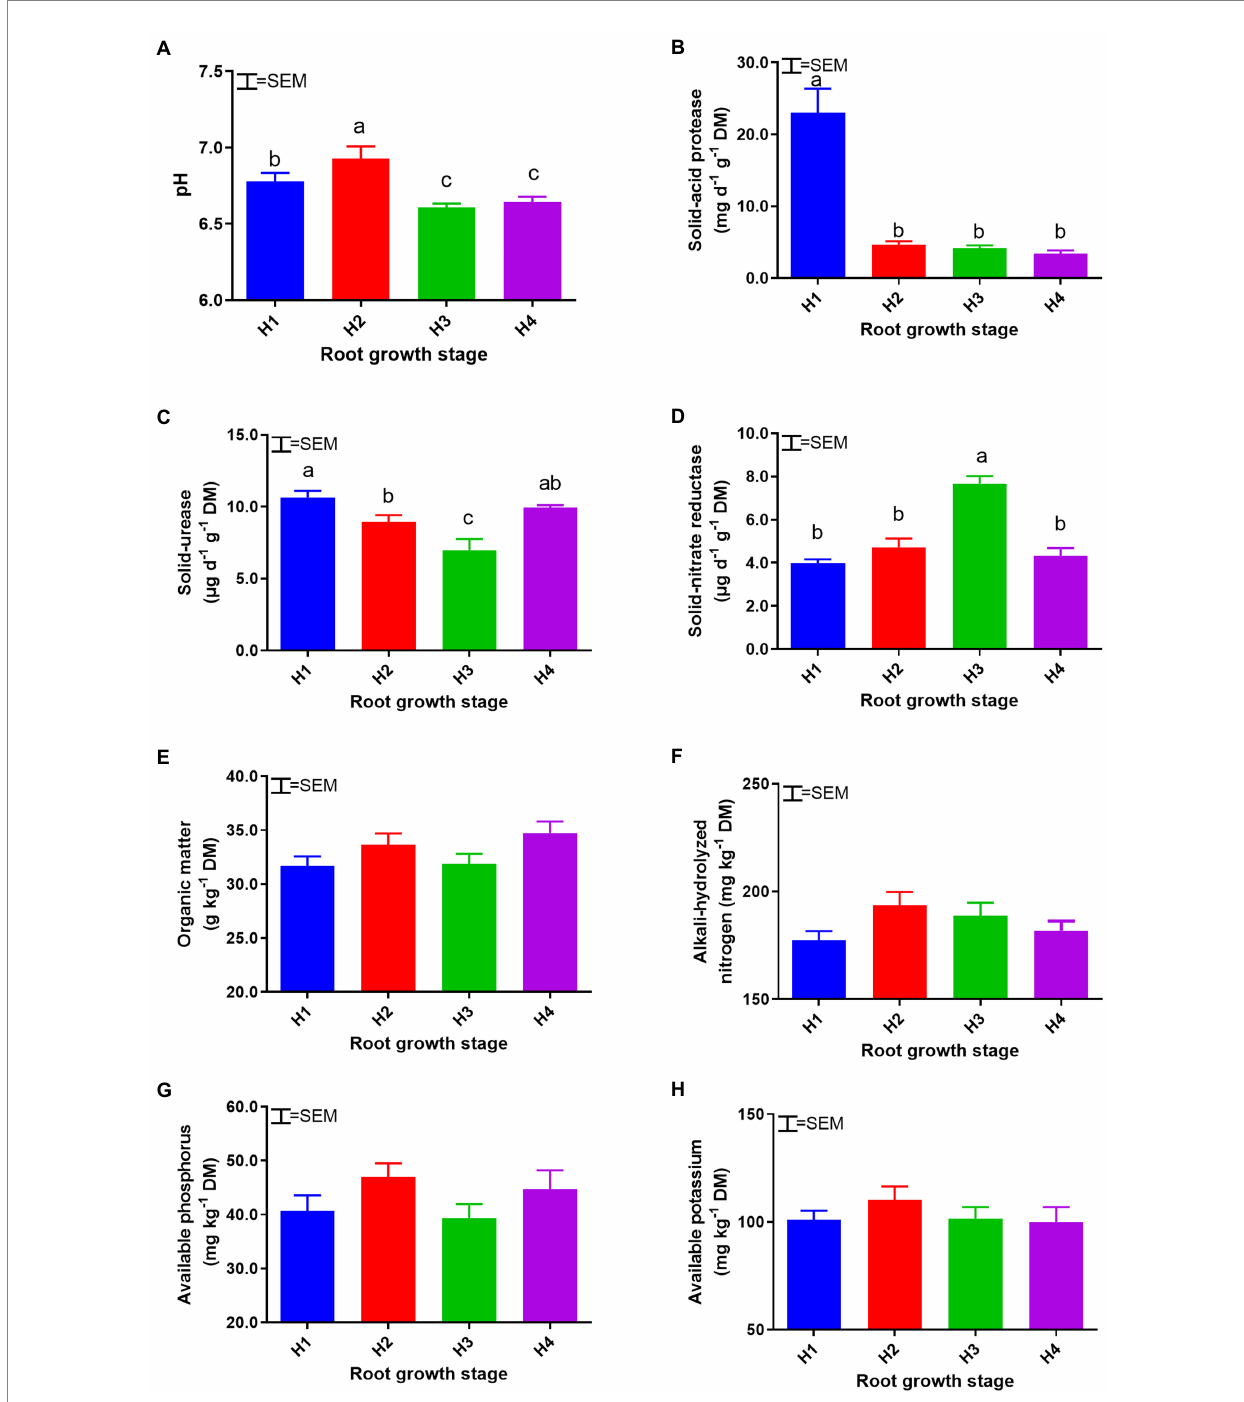
FIGURE 1 Soil chemical and enzymatic properties: pH (A) , solid-acid protease (B) , solid-urease (C) , solid-nitrate reductase (D) , organic matter (E) , alkali- hydrolyzable nitrogen (F) , available phosphorus (G) , and available potassium (H) at root growth stages H1–4. DM, dry matter. H1–4, root growth stages of mixed forage: January 4 (H1), March 14 (H2), April 21 (H3), and May 19 (H4). SEM, standard error of the mean ( n = 18). Means with different superscripts differ significantly ( p <